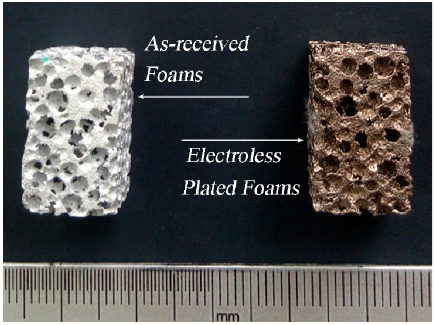
Figure 1. The macroscopic morphology of: ( left ) as-received foam; and ( right ) electroless plated foam (Ni/Al hybrid foams). Materials 2017 , 10 , 98